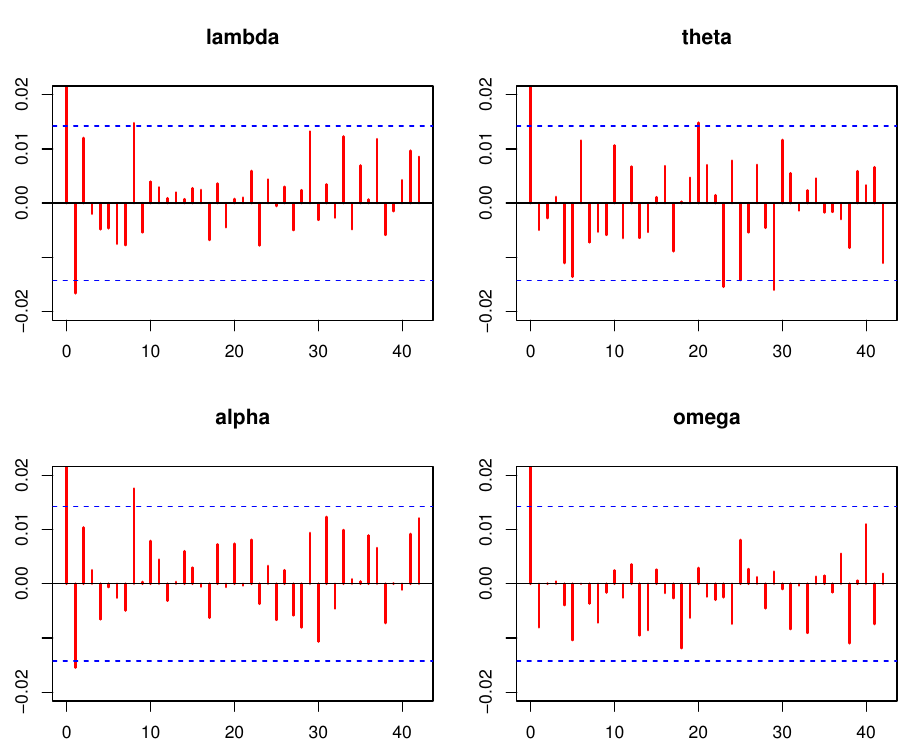
Figure 7. Plots of Bayesian analysis and performance of Gibbs sampling for DS1 dataset. Autocorre- lation plots of each CWE distribution